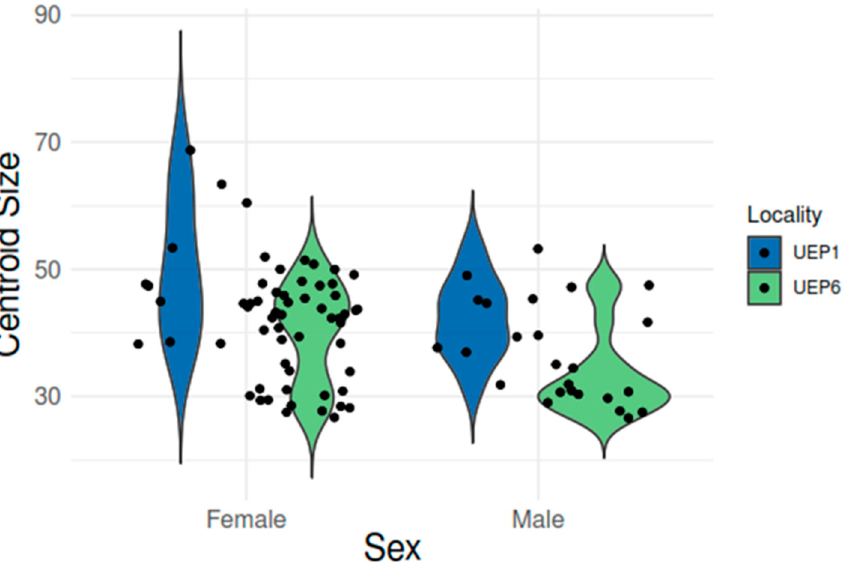
Figure 5. Violin diagram of the centroid size of P. magdalenae between location. Blue, UEP1— Ciénaga de Capote, and Green, UEP6—Ciénaga del Jobo.